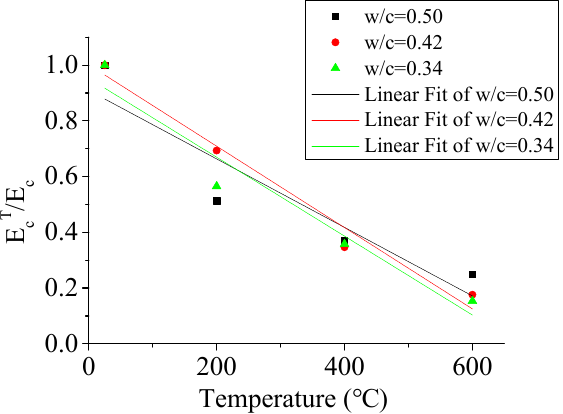
Figure 11. Elastic modulus of specimens after exposure to different temperatures.